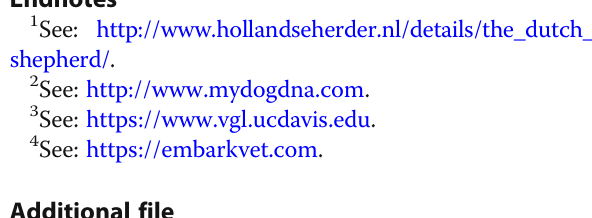
Additional file 1: Table S1. Multiplex DNA panel screening. Tested disorders within the multiplex DNA panel screening by MyDogDNA ™ , organised by type of disorder. Figure S1. Cross-section 2013 – 2015 Dutch breeding population of the long haired Dutch Shepherd Dog. Cross-section of the long haired Dutch Shepherd Dog breeding population for the years 2013 – 2015 in the Netherlands, combining the results of MyDogDNA ™ multiplex DNA panel screening with Sanger sequencing for the causal variant for Von Willebrand ’ s Disease type I (89%, n =42 from 47 breeding individuals). Litters are shown by birth year, most were not related. Resulting allele frequency in the breeding population is 2%. (DOCX 186